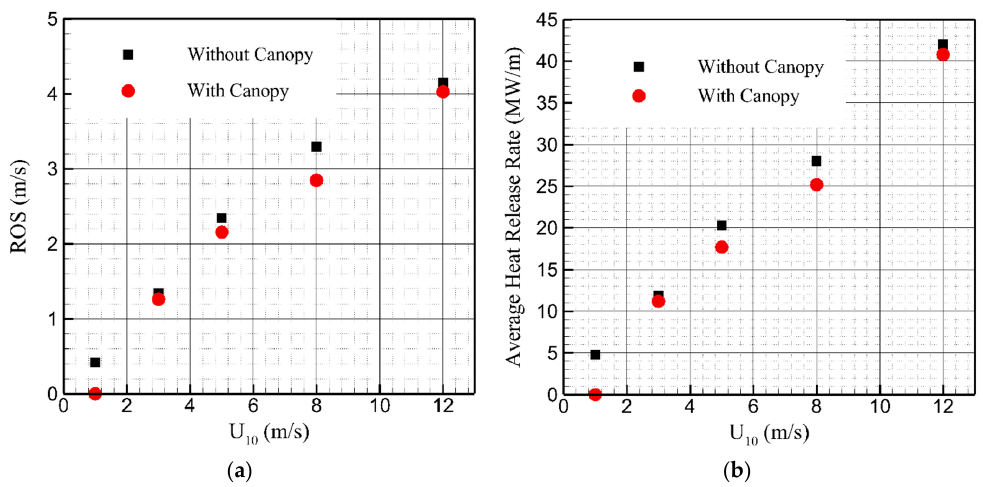
Figure 14. ( a ) Rates of fire spread obtained at steady state for different wind speeds in the presence of a canopy compared to those obtained for the same simulation conditions but without a canopy. ( b ) Average heat release rates obtained at steady state for different wind speeds in the presence of a canopy compared to those obtained for the same simulation conditions but without a canopy.